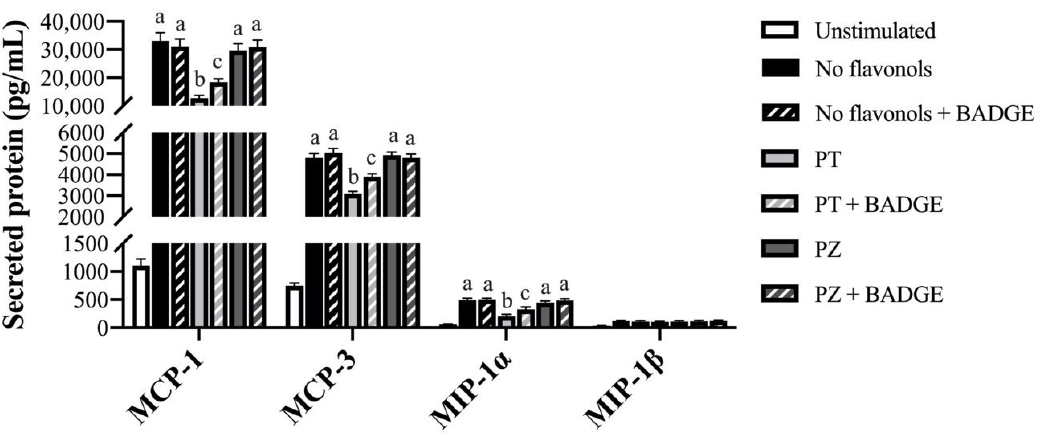
within cultures treated ± BADGE, p < 0.05.